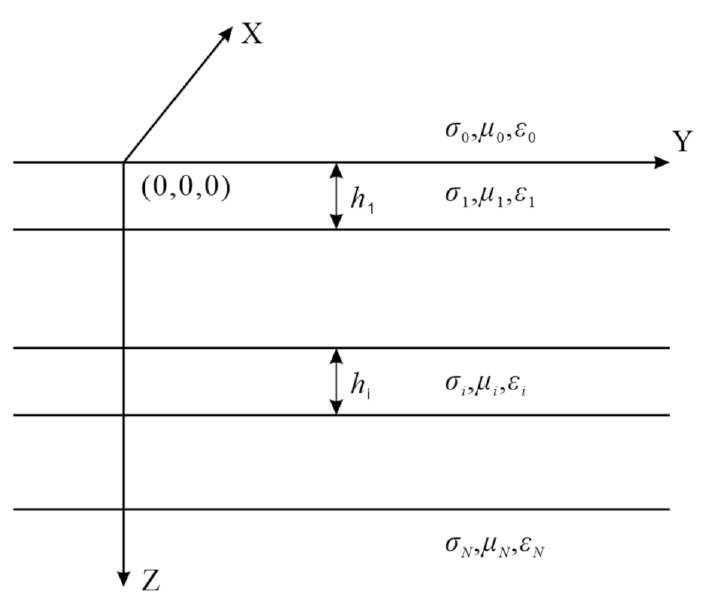
Figure 1. Layered earth model. The physical parameters of each layer are conductivity ( σ ), perme- ability ( µ ), and permittivity ( ε ). The thickness of each layer is denoted by h . A right-handed Cartesian coordinate system is